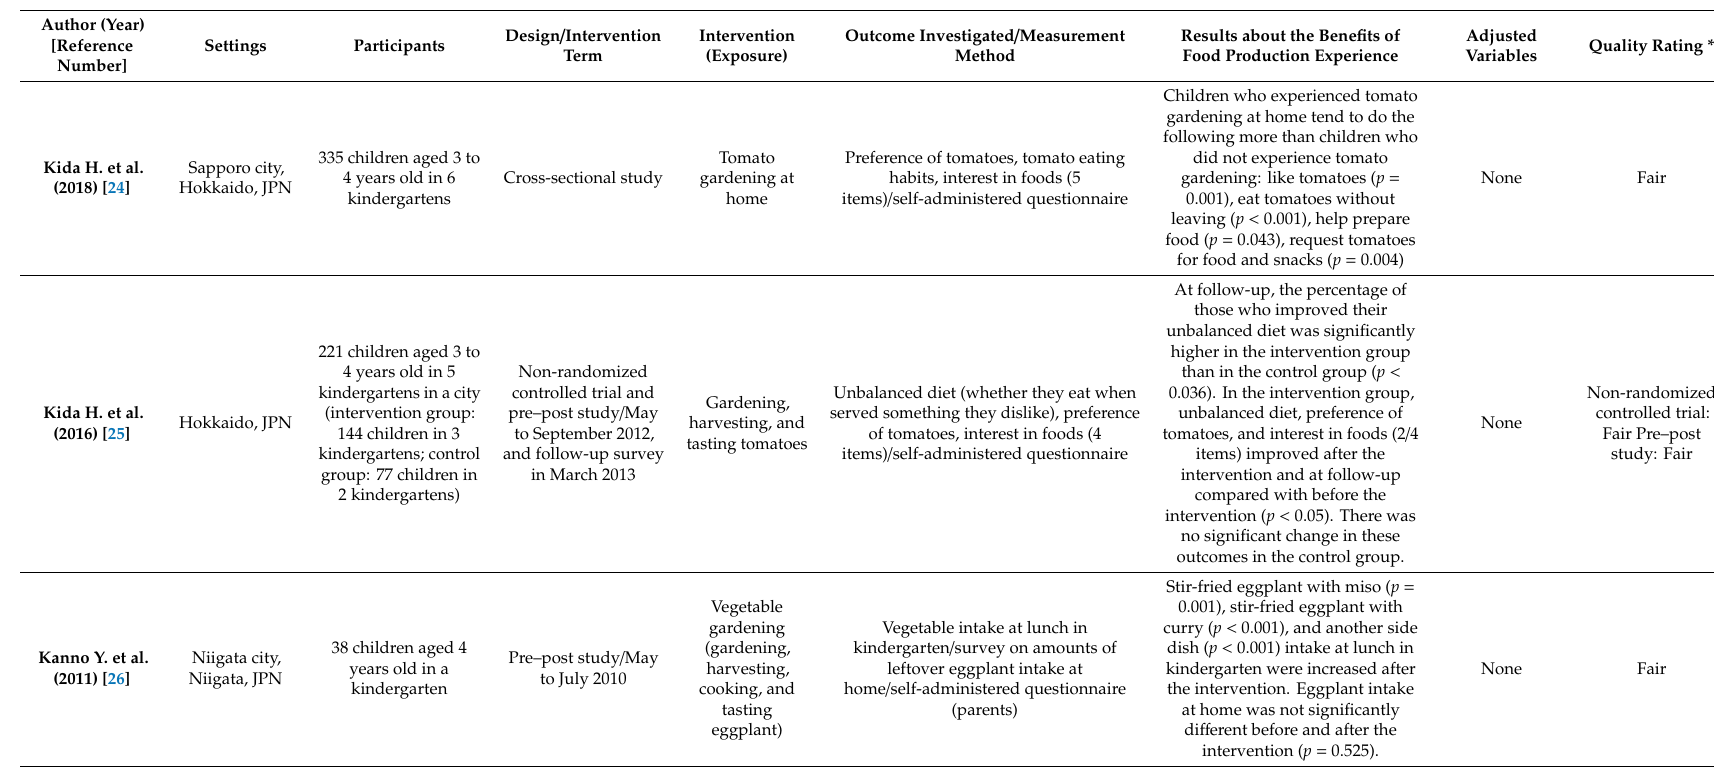
Table 1. Evidence table of food production experiences and dietary knowledge, dietary awareness, dietary behaviors and